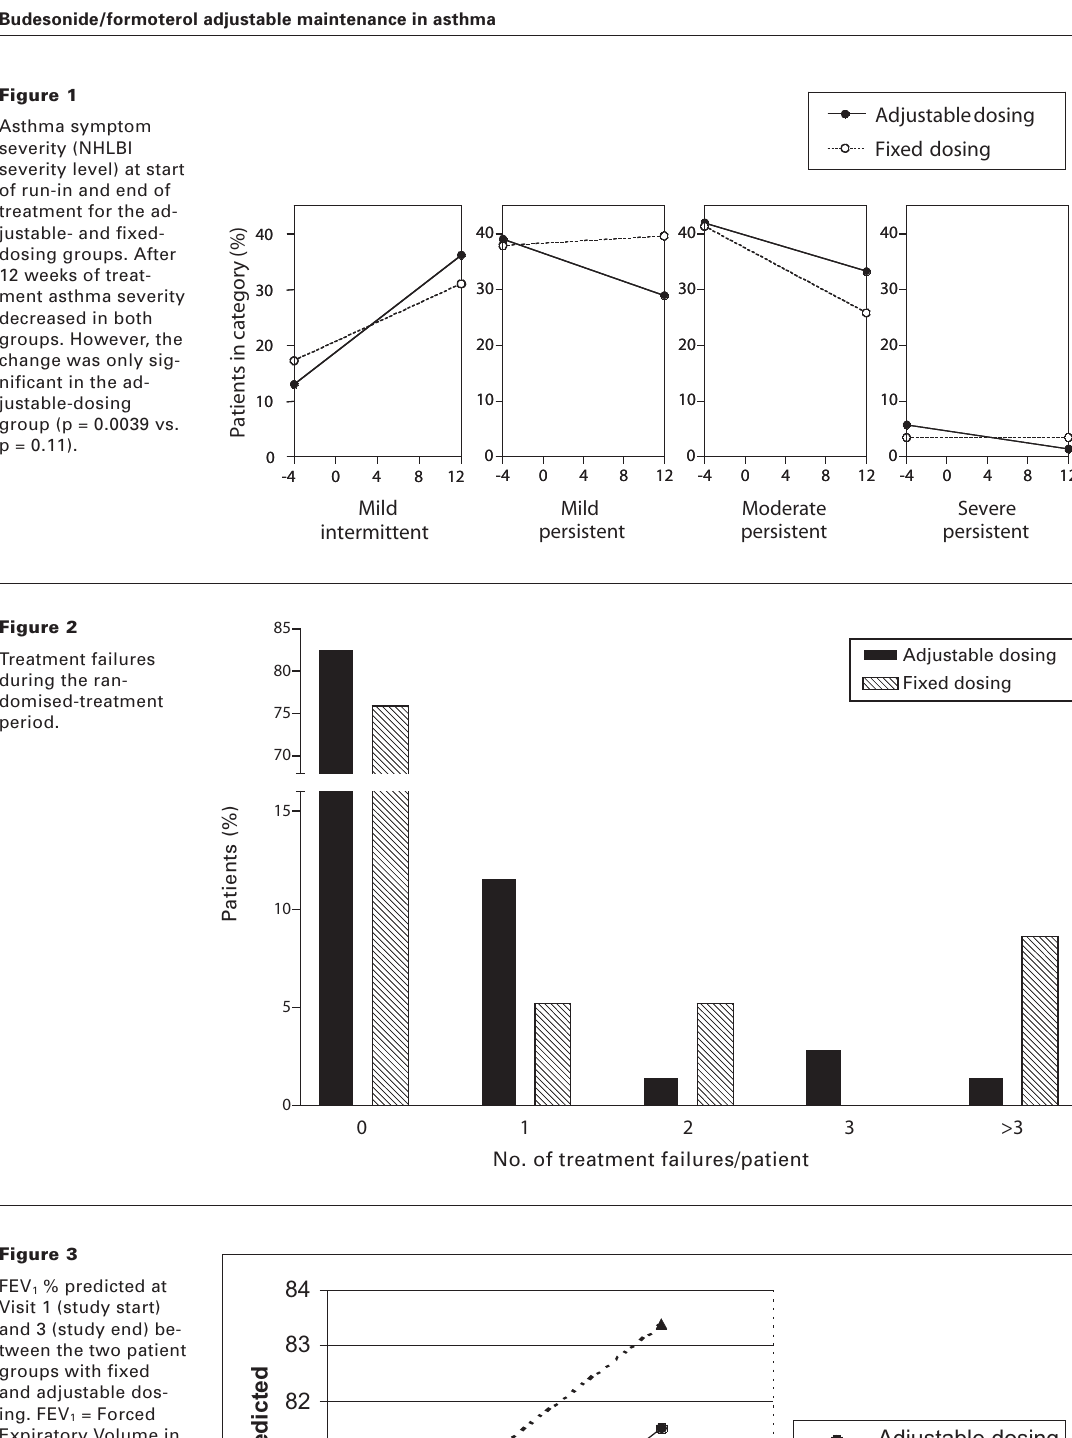
FEV 1 % predicted at Visit 1 (study start) and 3 (study end) be- tween the two patient groups with fixed and adjustable dos- ing. FEV 1 = Forced Expiratory Volume in